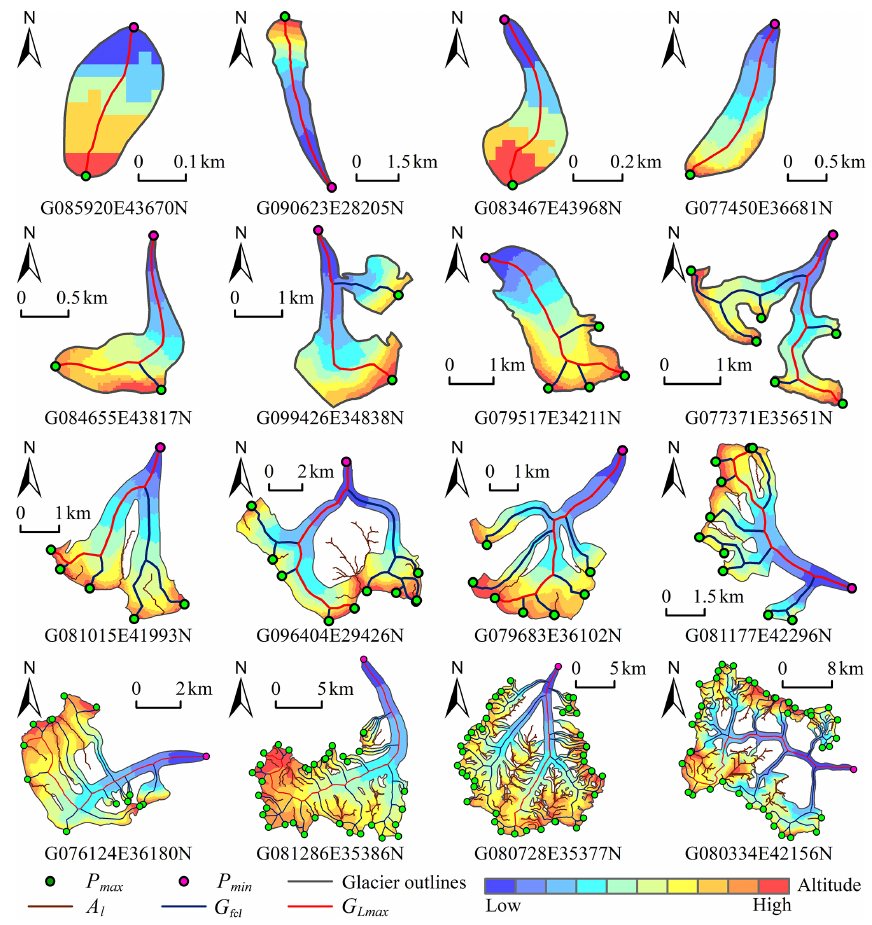
Figure 8. The centerlines for some typical glaciers ( P max and P min denote the local highest point and lowest point in the boundary of the glacier, respectively; A l denotes the auxiliary lines; G fcl and G Lmax denote the centerlines and the longest centerline of the glacier). Table 2. The information about validation